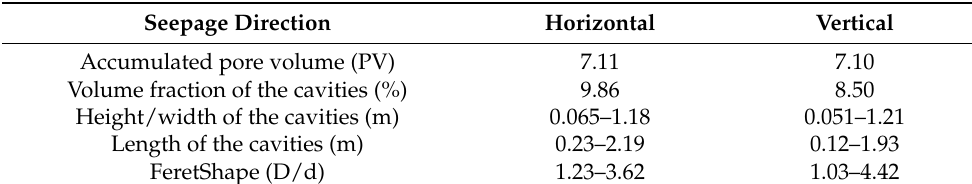
Figure 15. Image processing results showing the cavity segmentation for different seepage directions. ( a ) Horizontal flow, ( b ) vertical flow. Different colors are used to visually differentiate the individual cavities. Table 6. Statistics of the characteristic parameters for different seepage directions.